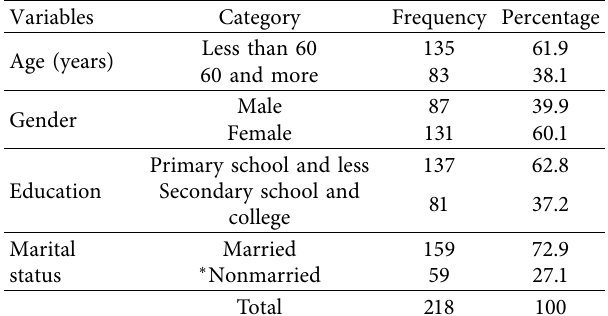
Table 1: Socio-demographic characteristics of the study